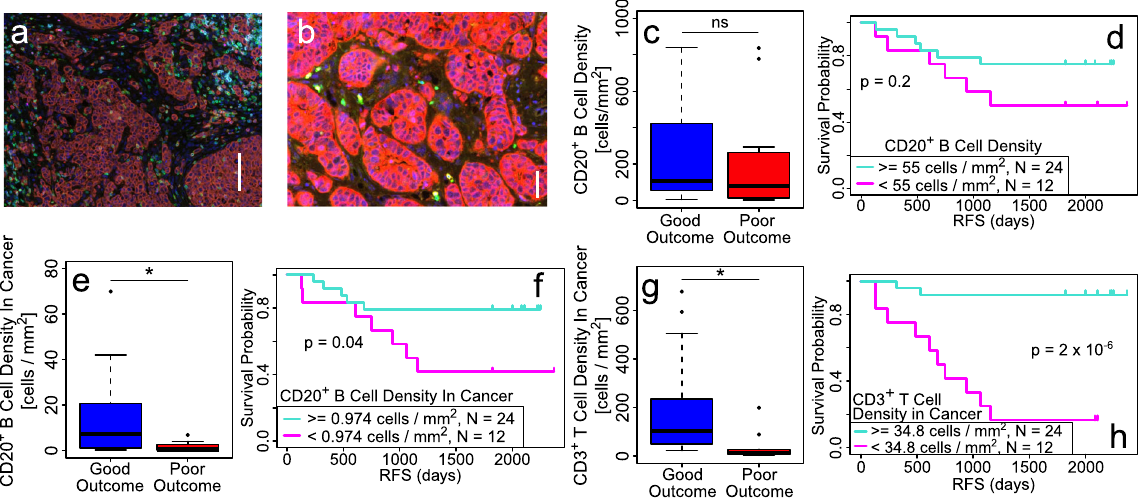
Fig. 1 Overall CD20 + B cell density is not clinically signi fi cant, but the density of TILs within cancer cell islands is signi fi cant. a Sample image of TNBC tissue illustrating the heterogeneity of the tumor microenvironment. Color code: T cells (CD3 + ; green), B cells (CD20 + ; cyan), cytotoxic T cells (CD8 + ; bright red), regulatory T cells (FoxP3 + , magenta), cancer cells (Pan-cytokeratin cells; dark brownish red), and nuclei (DAPI; dark blue). Cancer cell islands correspond to clusters of cancer cells (dark brownish red). Scale bar = 100 μ m. b Example of cancer cell islands interspersed with stroma. Color code: T cells (CD3 + ; green), B cells (CD20 + ; cyan), cancer cells (Pan-cytokeratin cells; red), and nuclei (DAPI; dark blue). Scale bar = 50 μ m. c , d The density of B cells overall in tumor does not differentiate between good vs. poor outcome. c Box and whisker plot showing CD20 + B cell density in the entire tumor is not signi fi cantly different between good ( n = 24) vs. poor ( n = 12) outcome. Center line represents the median, box limits represent the upper and lower quartiles, whiskers indicate maximum and minimum values within 1.5 interquartile ranges of the upper and lower quartiles; individual points are outliers. d Relapse-free survival (RFS) plot showing that CD20 + B cell density in the entire tumor is not a signi fi cant factor in TNBC clinical outcome, using a threshold value of 55 cells/mm 2 as described in “ Methods ” . e – g Density of B and T cells within cancer cell islands is clinically signi fi cant. e Plot showing density of CD20 + B cells within cancer cell islands is higher for good ( n = 24) vs. poor ( n = 12) outcome ( p = 0.02). Center line represents the median, box limits represent the upper and lower quartiles, whiskers indicate maximum and minimum values within 1.5 interquartile ranges of the upper and lower quartiles; individual points are outliers. f RFS plot showing the clinical signi fi cance of density of CD20 + B cells within cancer cell islands using a threshold value of 0.974 cells/mm 2 (see “ Methods ” ). g Plot showing density of CD3 + T cells within cancer cell islands is higher for good ( n = 24) vs. poor ( n = 12) outcome ( p = 0.01). Center line represents the median, box limits represent the upper and lower quartiles, whiskers indicate maximum and minimum values within 1.5 interquartile ranges of the upper and lower quartiles; individual points are outliers. h RFS plot showing the clinical signi fi cance of density of CD3 + T cells within cancer cell islands using a threshold value of 34.8 cells/mm 2 (see “ Methods ” ). P -values in box plots are determined by unpaired, two-tailed Student t -tests. ns: not signi fi cant; * p < 0.05; ** p < 0.01; *** p < 0.001; **** p < 1 × 10 − 4 outcome (good ( n = 24): 2.4 × 10 2 /mm 2 ; poor ( n = 12): 2.2 × 10 2 / mm 2 ; p = 0.8, ROC AUC = 0.6) (Fig. 1c). Relapse-free survival (RFS) curves using a B cell density threshold of 55 cells/mm 2 (see Methods) were non-signi fi cant for clinical outcome patients